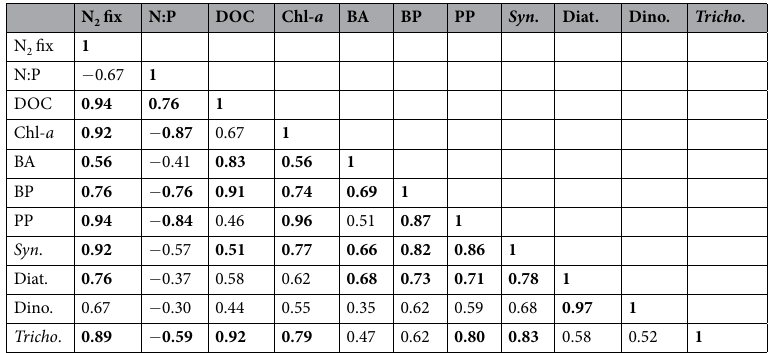
Table 2. Pearson linear correlation matrix between the different variables tested before, during, and after the Trichodesmium bloom in the SEMS from January to March 2015. Values in bold show statistically significant relationships between the variables (alpha = 0.05, n = 9–10). Syn .: Synechococcus ; Diat.: diatoms; Dino.: dinoflagellates; Tricho .: Trichodesmium